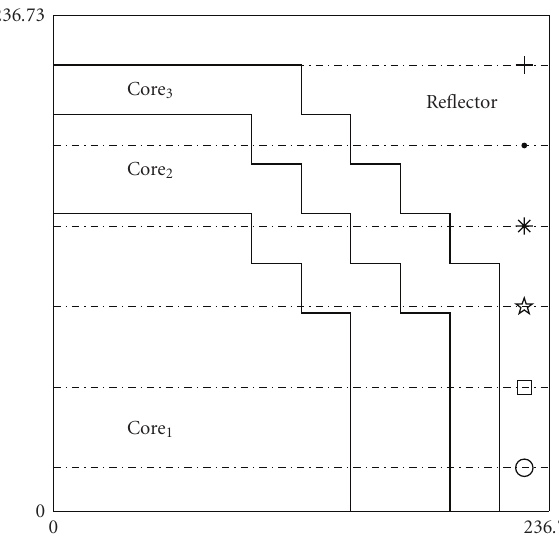
Figure 3: Geometrical configuration of the ELSY-like system. The transverse lines along which graphs are plotted in the following figures are indicated.